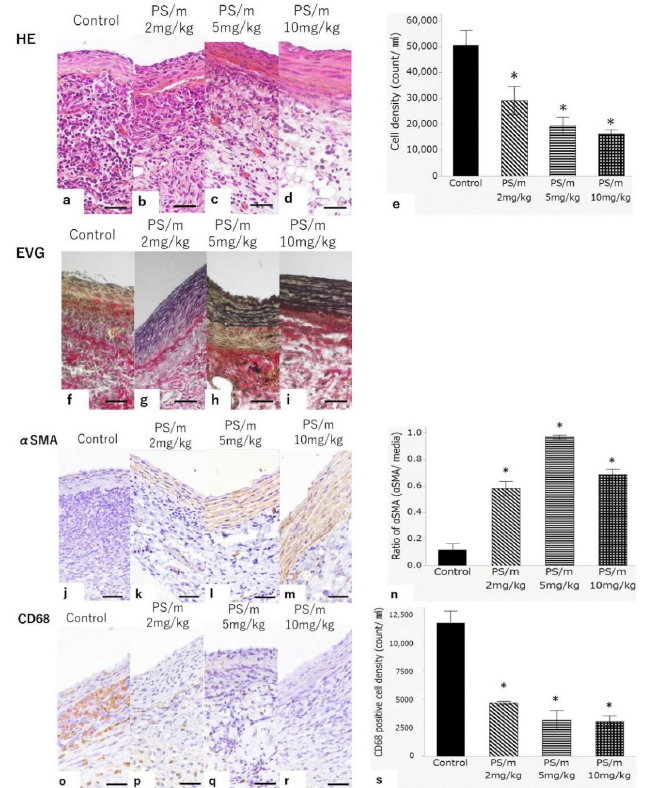
Figure 4. Histological appearance of AAA treated with phosphate-buffered saline (PBS) or PS/m. ( a – d ) hematoxylin and eosin (HE) stain, ( f – i ) Elastica van Gieson (EVG) stain, ( j – m ) α